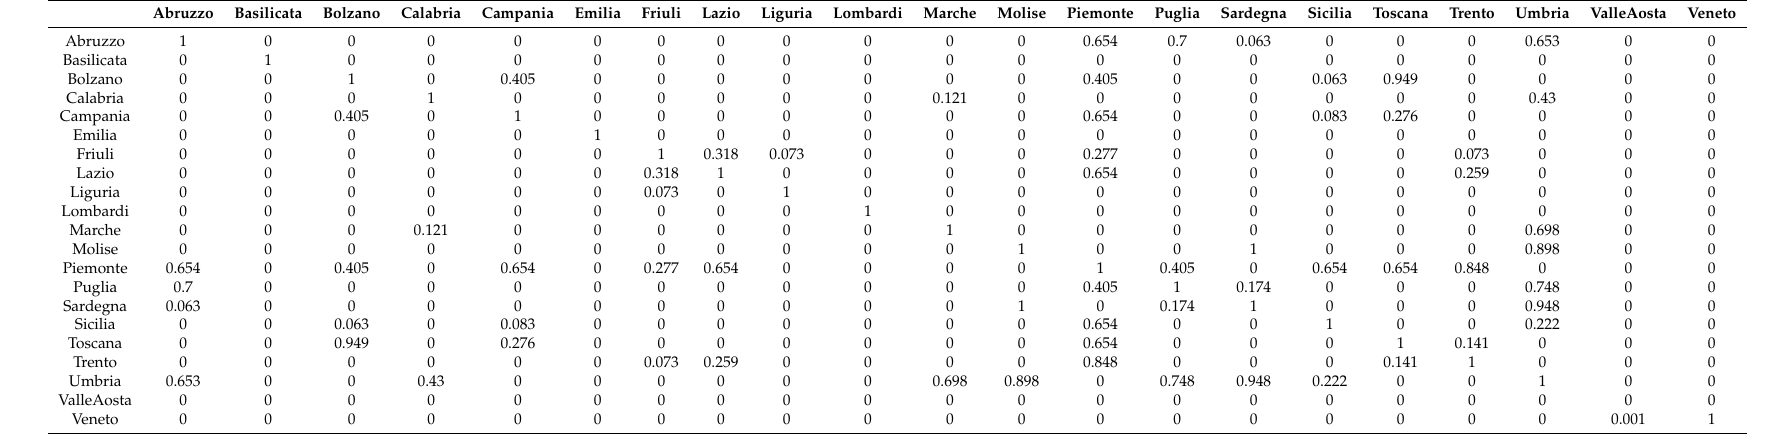
Table A42. Similarity values of Discharged/Healed network in the fifth